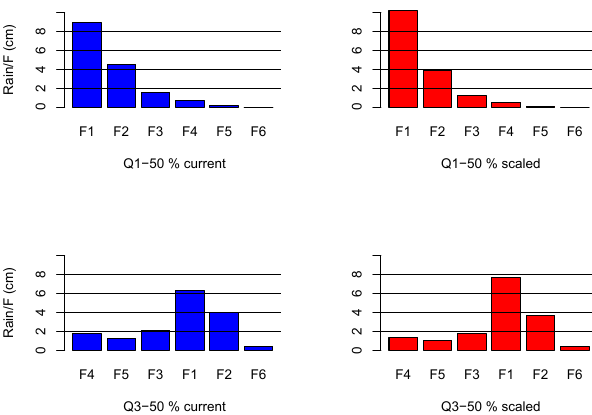
Figure 5. Scaling total volume of rainfall with temperature for Min- neapolis (1901–2014 daily rainfall). Grey dots are rainfall tempera- ture pairs and the colored dots are the extreme percentiles. The grey dashed line represents a scaling of